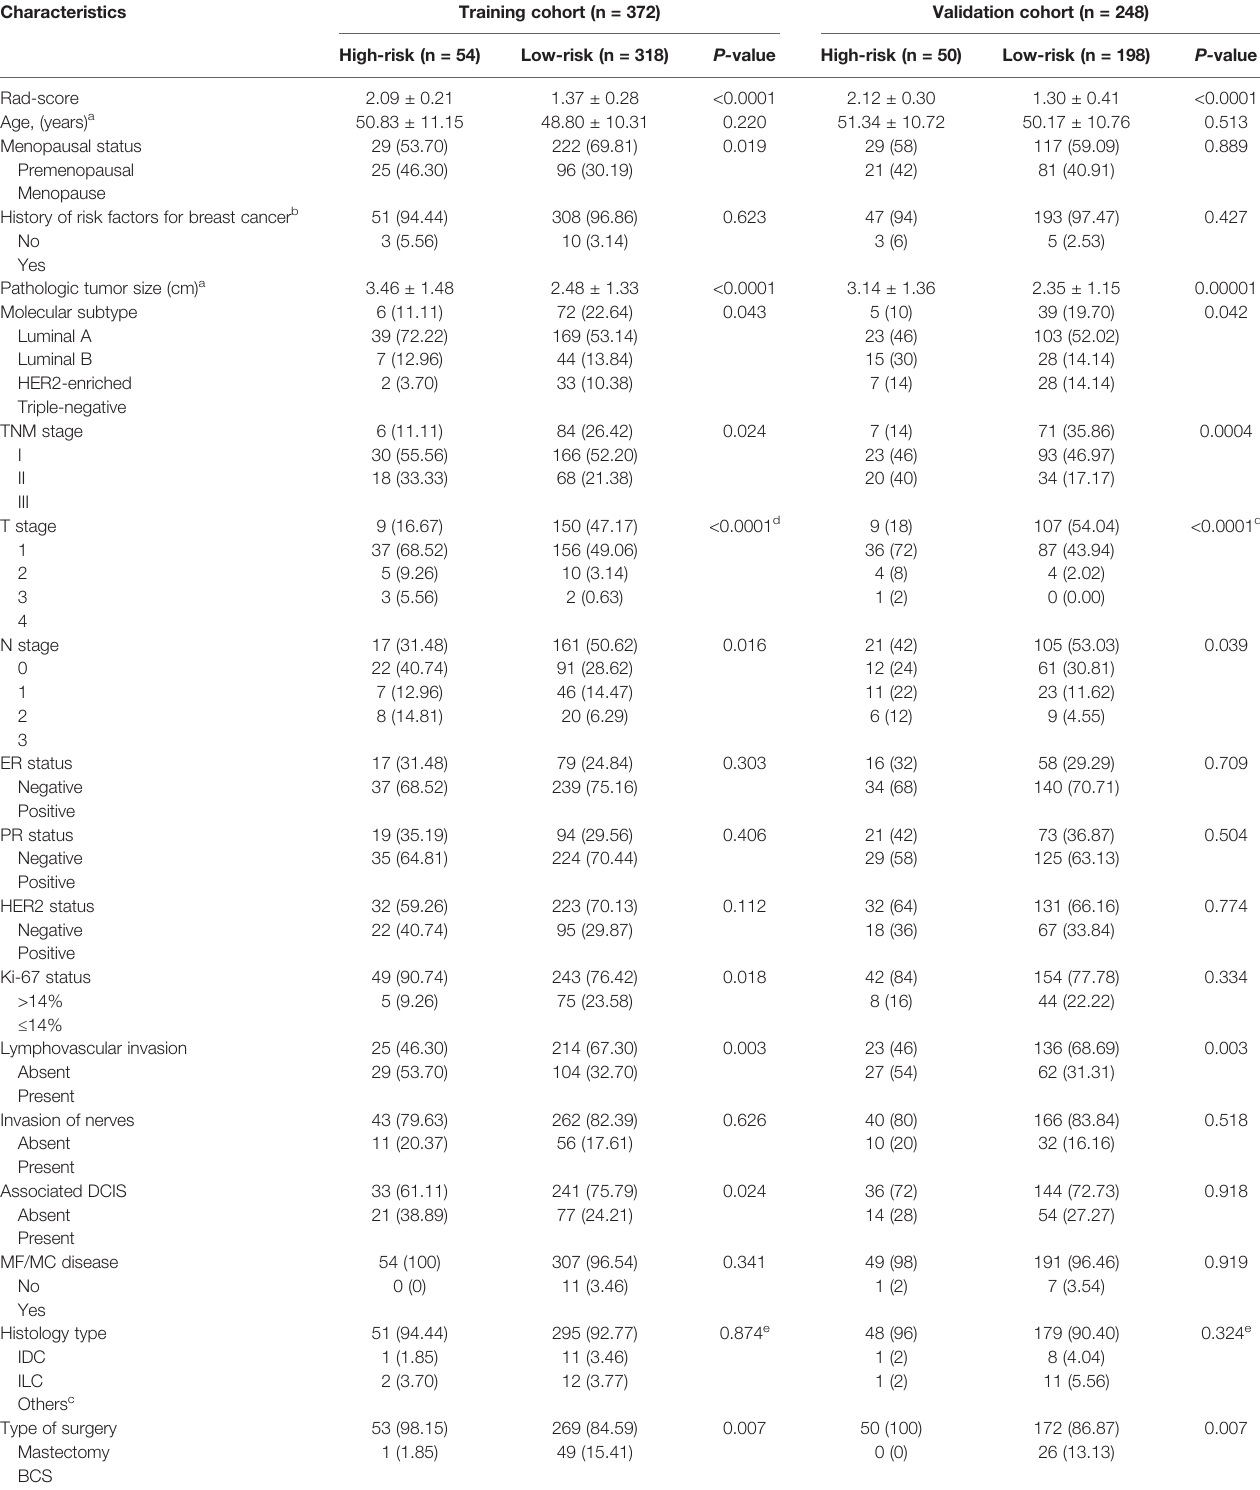
TABLE 2 | Characteristics of patients according to the risk group based on radiomics signature in the training and validation cohorts.